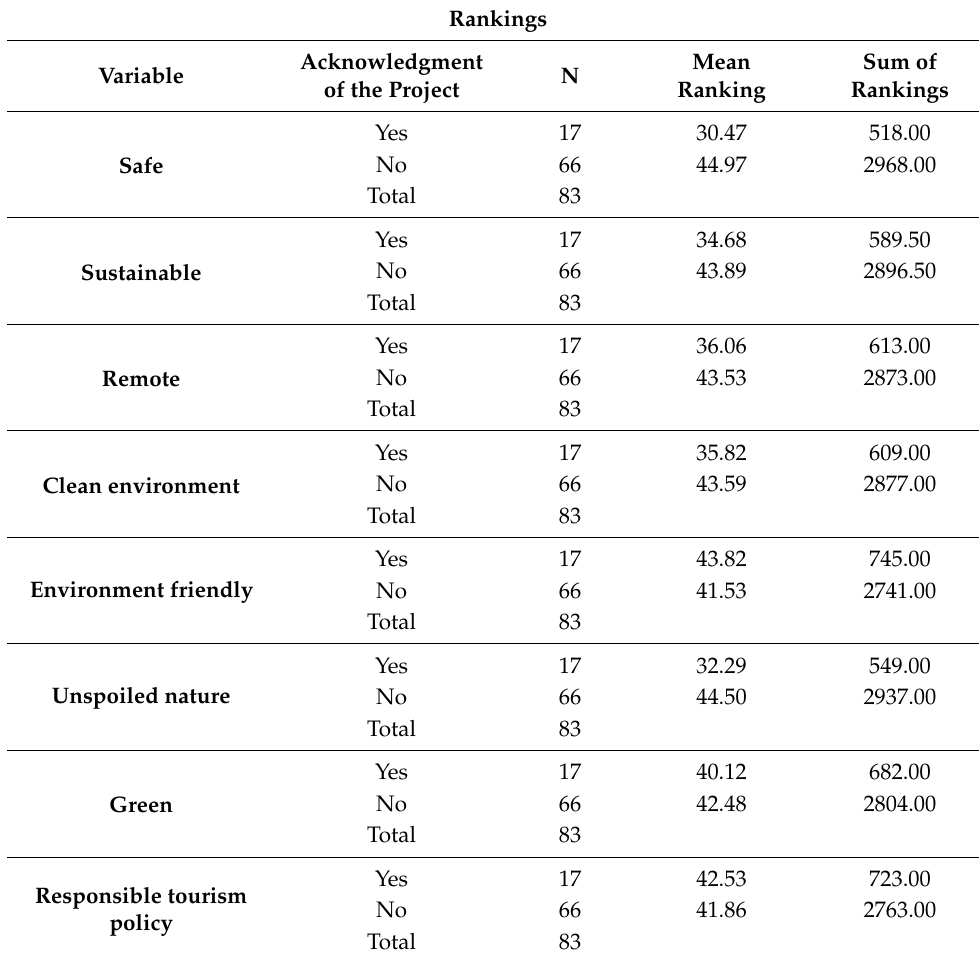
Table 3. Evaluation of the destination attributes and tourists’ acknowledgment of the volunteer tourism project, PS Imago Pro, own